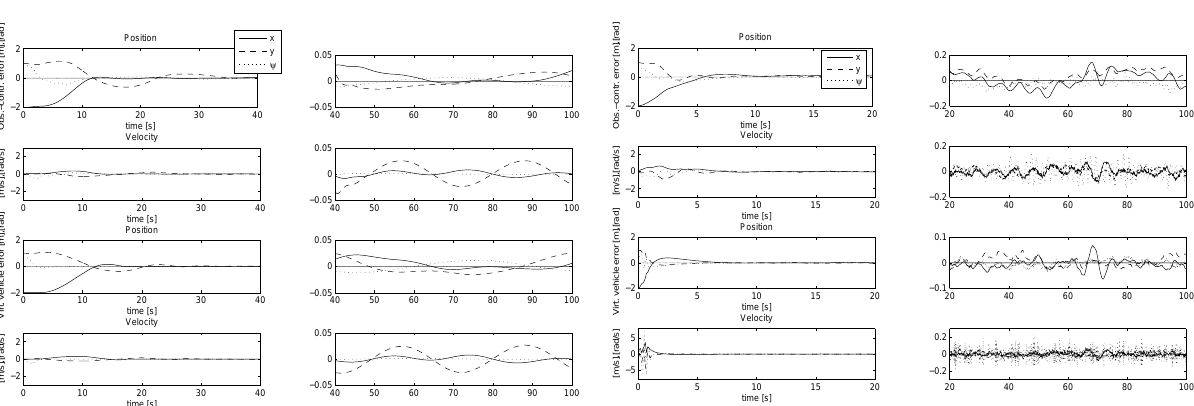
Figure 9: Performance of the dynamic observer scheme (top two rows) and kinematic observer scheme (bot- tom two rows) under model parameter errors, ve- locity disturbances, force disturbances and mea- surement